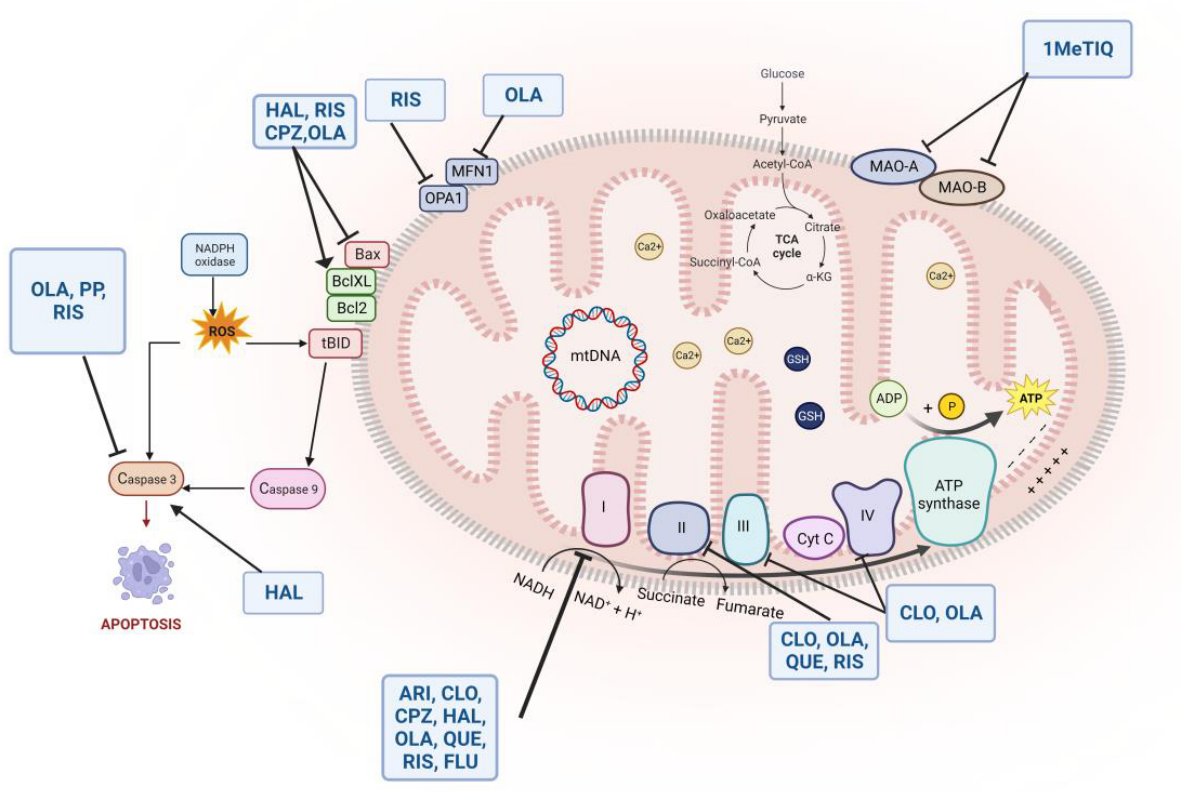
Figure 3. Antipsychotics can interact with several proteins involved in the regulation of mitochon- drial functions, including energy expenditure, free radicals’ production, and cell survivance. For a comprehensive acknowledgment of antipsychotics’ sites of action at the mitochondrial level, please see the corresponding text. 1MeTIQ = 1-Methyl-1,2,3,4-tetrahydroisoquinoline; ARI = aripiprazole; CLO = clozapine; CPZ = chlorpromazine; FLU = fluphenazine; GSH = glutathione; HAL = haloperi- dol; MAO = monoamine oxidase; MFN1 = mitofusin 1; OLA = olanzapine; OPA1 = optic atrophy 1; QUE = quetiapine; PP = paliperidone; RIS = risperidone. Created with BioRender.com; last accessed on 23 February 2023.